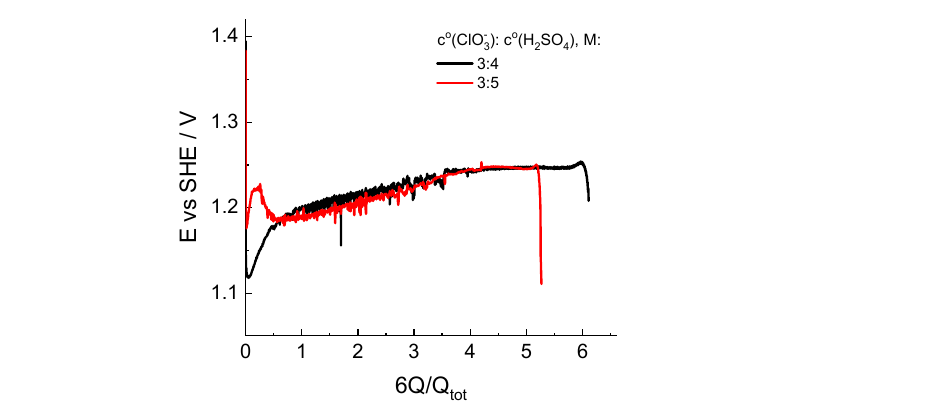
Figure 6. Dependence of the redox potential of the solution measured by an indicator electrode in the catholyte reservoir in the course of potentiostatic load experiments at a voltage of 0.7 V. Initial compositions of the catholyte are indicated in the legend.